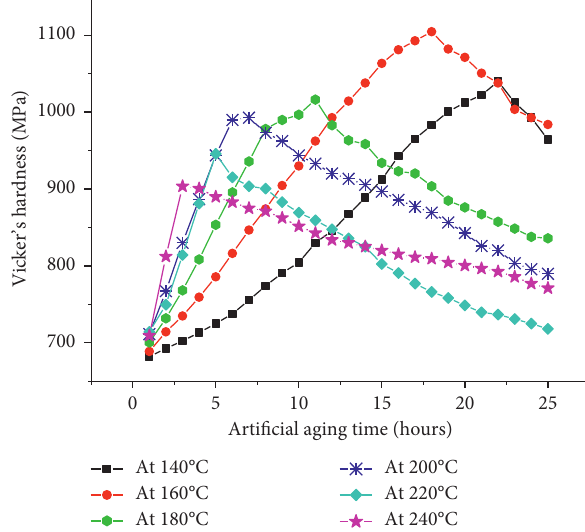
Figure 1: The hardness variations with artificial aging